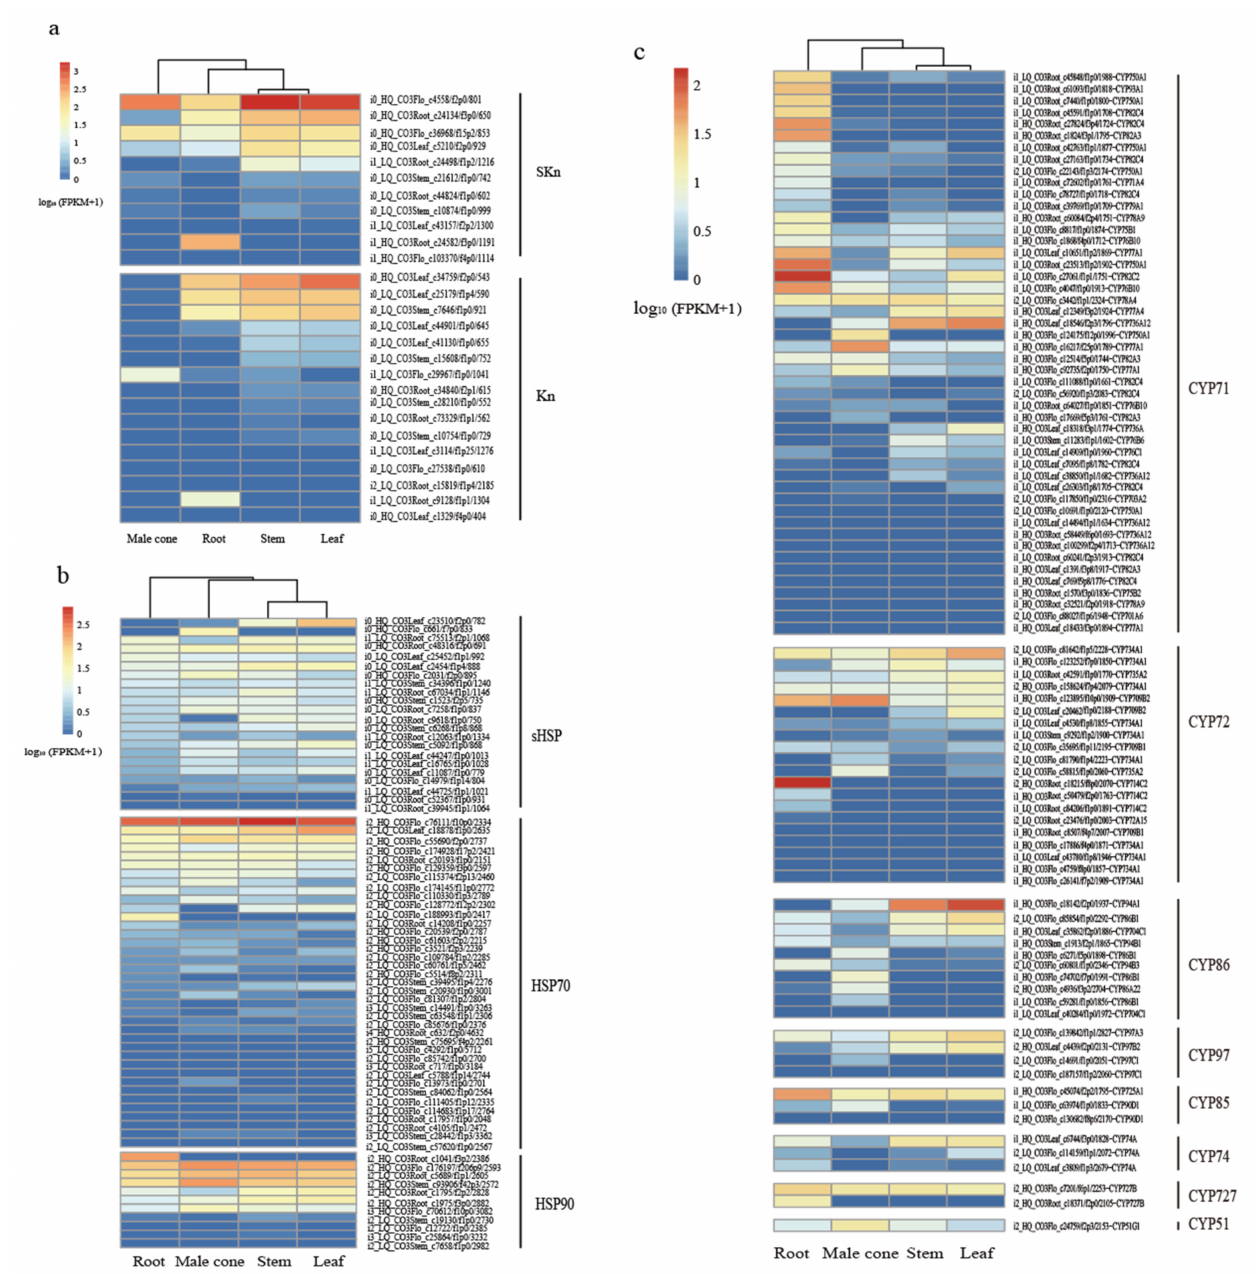
Figure 7. Expression profiles of different genes families in four tissues. ( a ) dehydrin (DHN) genes families; ( b ) heat shock protein (HSP) genes families; ( c ) cytochrome P450 (CYP450) genes